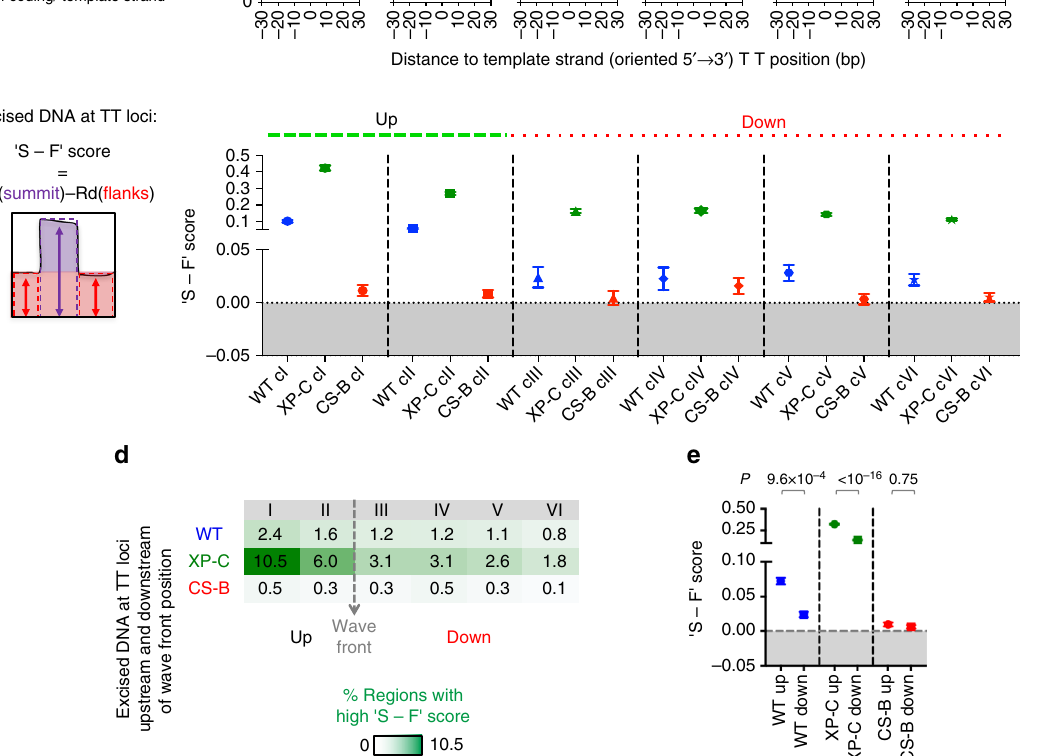
Coding/ non-template strand Non-coding/ template strand